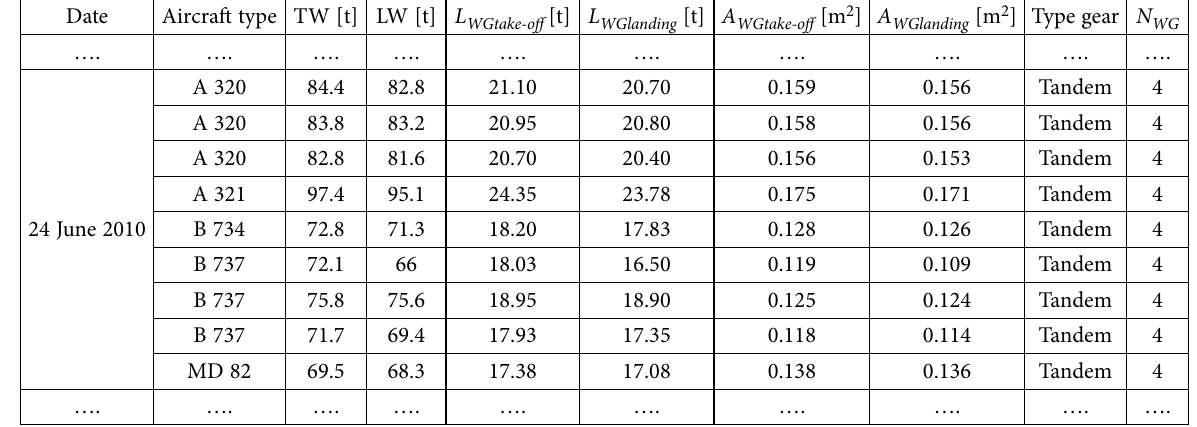
Table 2. Sample data excerpt from air traffic sequence on runway 10/28